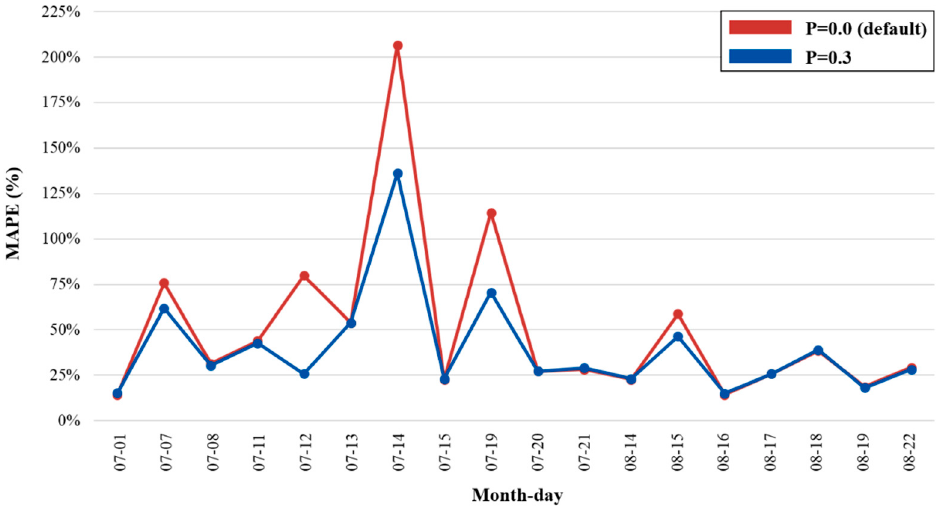
Figure 9. The daily MAPE for the BIPV power prediction with dropout observation for overcast days.